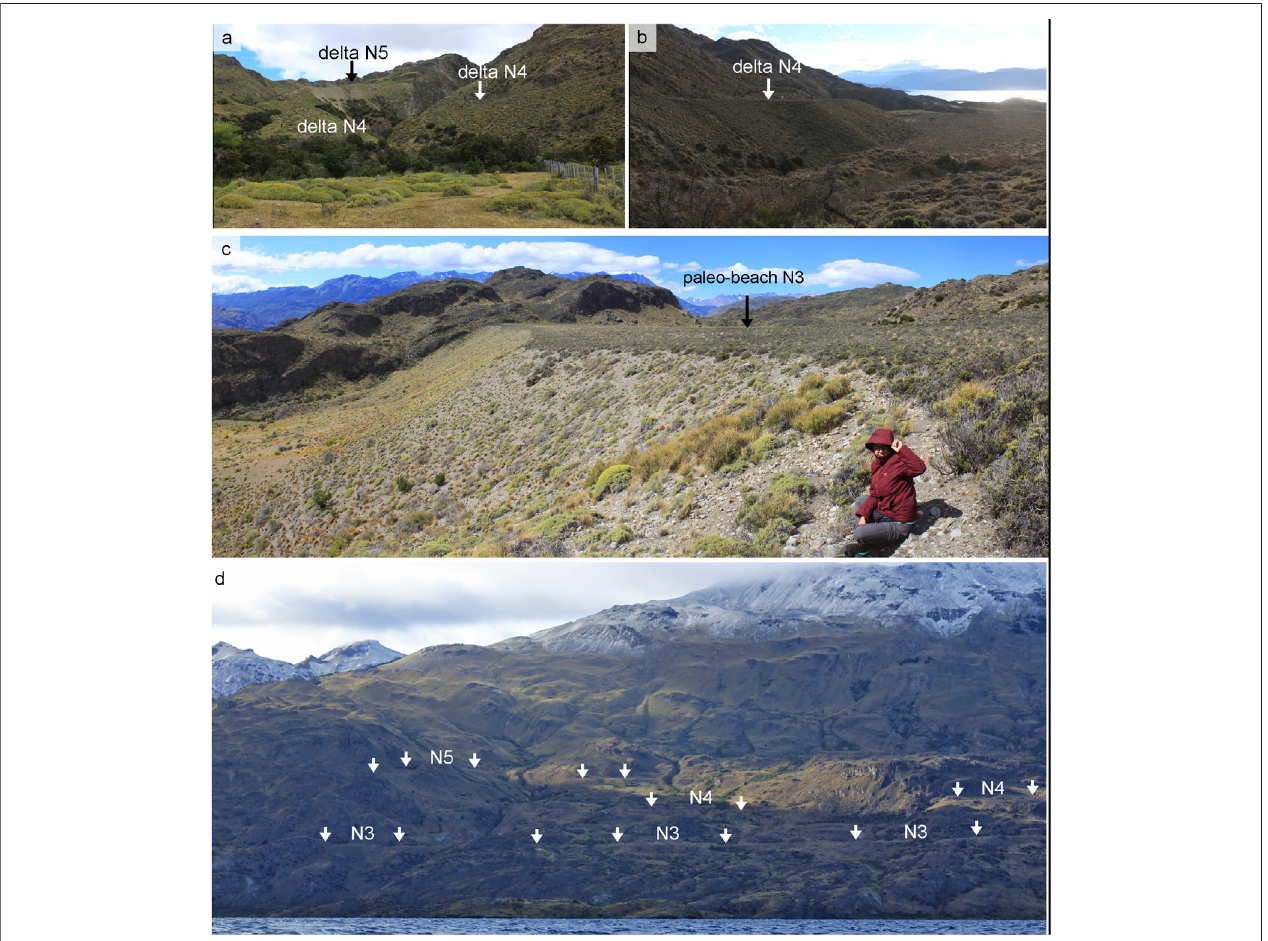
FIGURE 7 | (A – C) Field photographs from the Buena Vista sector. (D) Shorelines between the Dos Arroyos and Buena Vista sectors. Note the remarkable preservation and continuity of N3. See location in Supplementary Figure S7 .